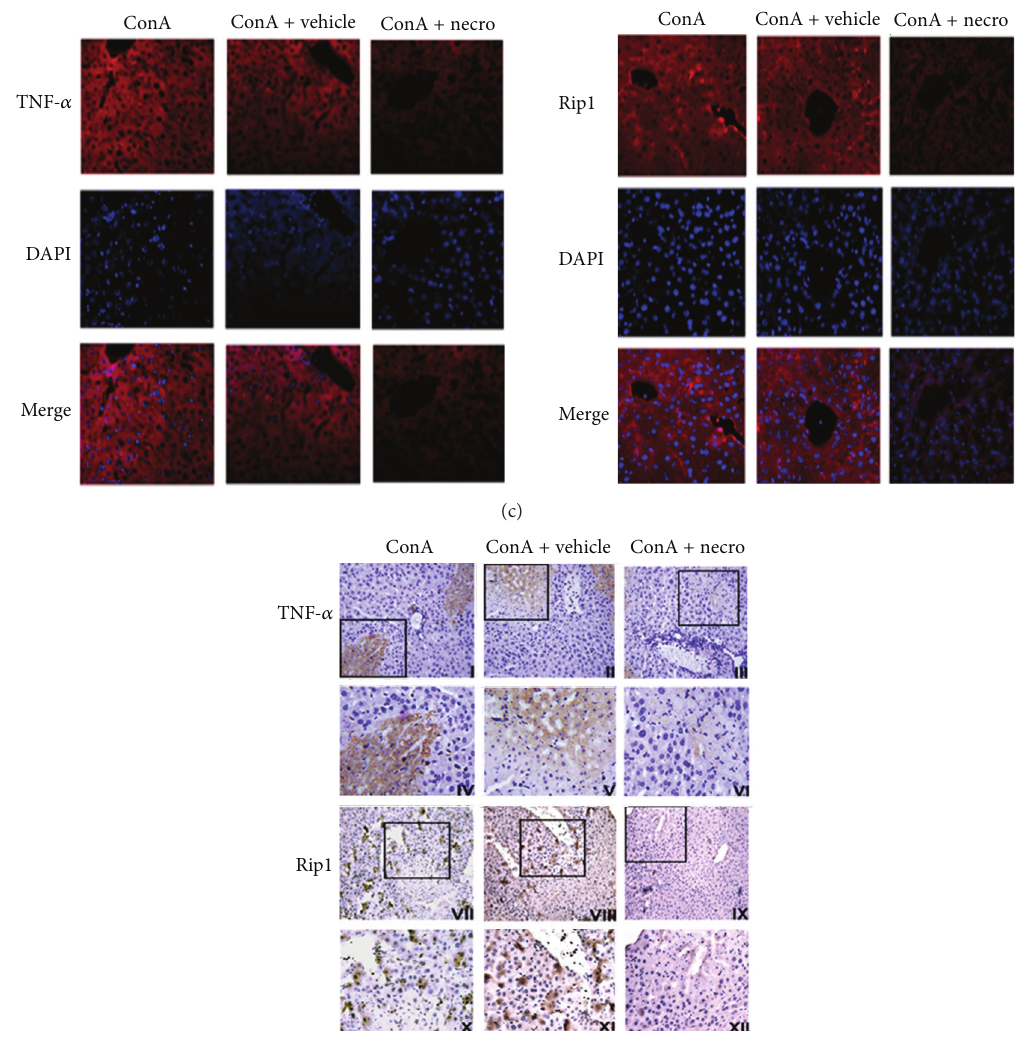
Figure 4: (a) Effects of Nec-1 on ConA-induced hepatic TNF- 𝛼 and RIP1 protein expression. (b) Caspase 3 activity in cytosolic extracts 12h after ConA-induced liver injury and pretreatment with vehicle or Nec-1 versus ConA model mice. (c) Localization of IL2 and IL6 in liver tissues detected by immunofluorescence (original magnification: × 200). (d) Immunohistochemical staining for RIP1 and TNF- 𝛼 after ConA- induced hepatitis in the negative control group (I, IV, VII, and X), the vehicle group (II, V, VIII, and XI), and the Nec-1-treated group (III, VI, IX, and XII). These experiments were repeated three times, and representative results are shown. The small image is × 200 magnification, and the enlarged pictures show the framed parts in the small images ( × 400).